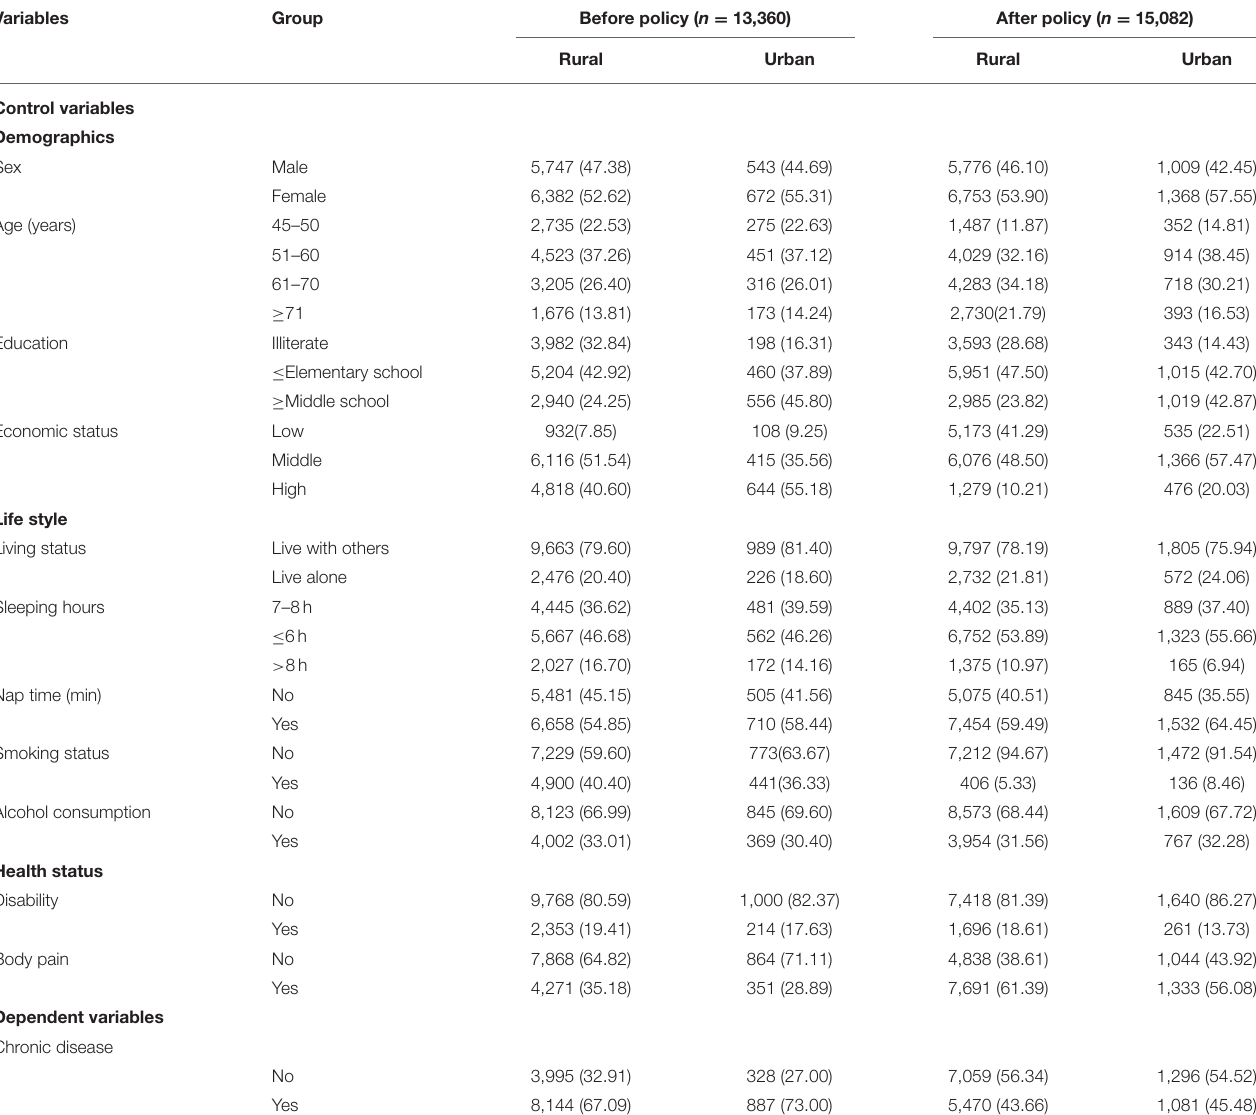
TABLE 2 | Variable definitions and summary